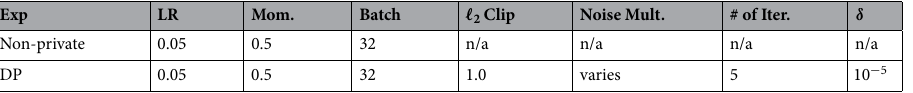
Table 1. Hyperparameters chosen for non-private and differentially private classifiers. The neural networks and VQCs use the same hyperparameters for both classification tasks. The learning rate (LR) is the same across all experiments. Different noise multipliers are used to compare differentially private networks. The “varies” noise parameter means that multiple values of noise have been used in the DP-neural network and DP-VQC experiments. ε also varies among DP experiments as it directly depends on the noise multiplier. The last four hyperparameters are applicable only with differentially private optimizers.